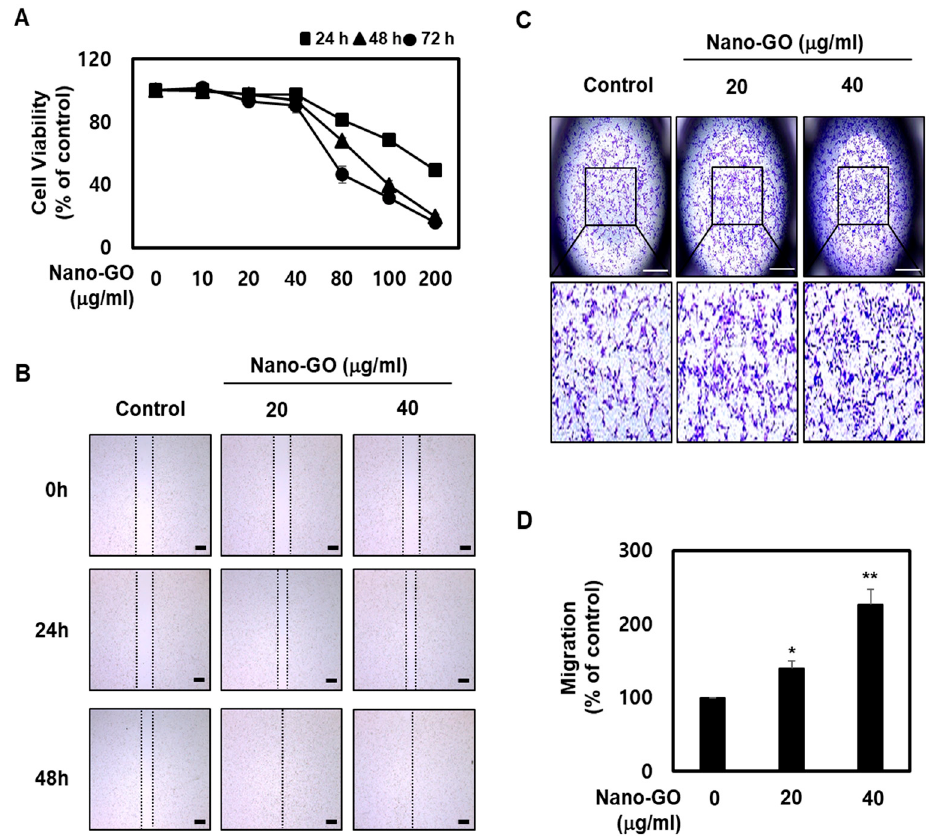
Figure 2. Effect of Nano-GO on RPE cell migration. ( A ) RPE cells were treated with Nano-GO (0, 10, 20, 40, 80, 100, and 200 µ g/mL) for 24, 48, and 72 h. RPE cell viability was measured using the Cell Counting Kit-8 assay. ( B ) RPE cells were treated with Nano-GO (20 and 40 µ g/mL) for 24 or 48 h. Migratory RPE cell images were taken at 0, 24, and 48 h after scratching was applied. The lines show the boundaries of the transferred RPE cells (scale bar; 100 µ m). Transwell migration assay. RPE cells were allowed to move through the membrane for 24 h in the presence or absence of Nano-GO (20 and 40 µ g/mL). Representative images of migrated RPE cells ( C ) and quantification ( D ) are shown (scale bar; 50 µ m). All data are presented as the mean ± SEM ( n = 3). * p < 0.05 and ** p < 0.01 compared to the